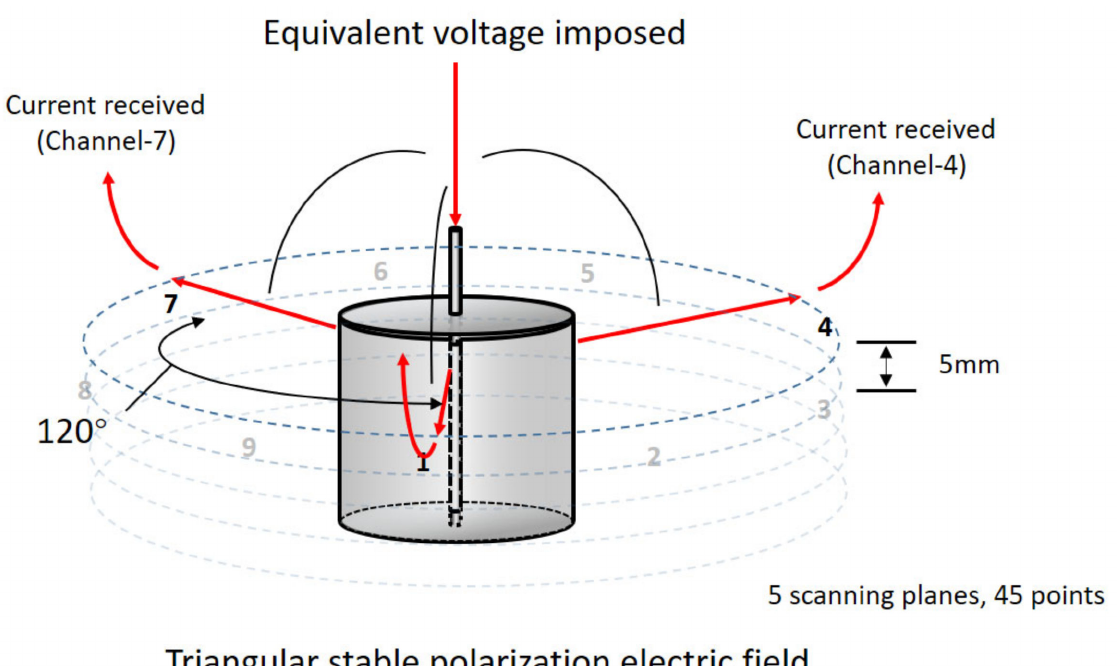
Figure 2. The schematic diagram of the conductivity uniformity test for anode